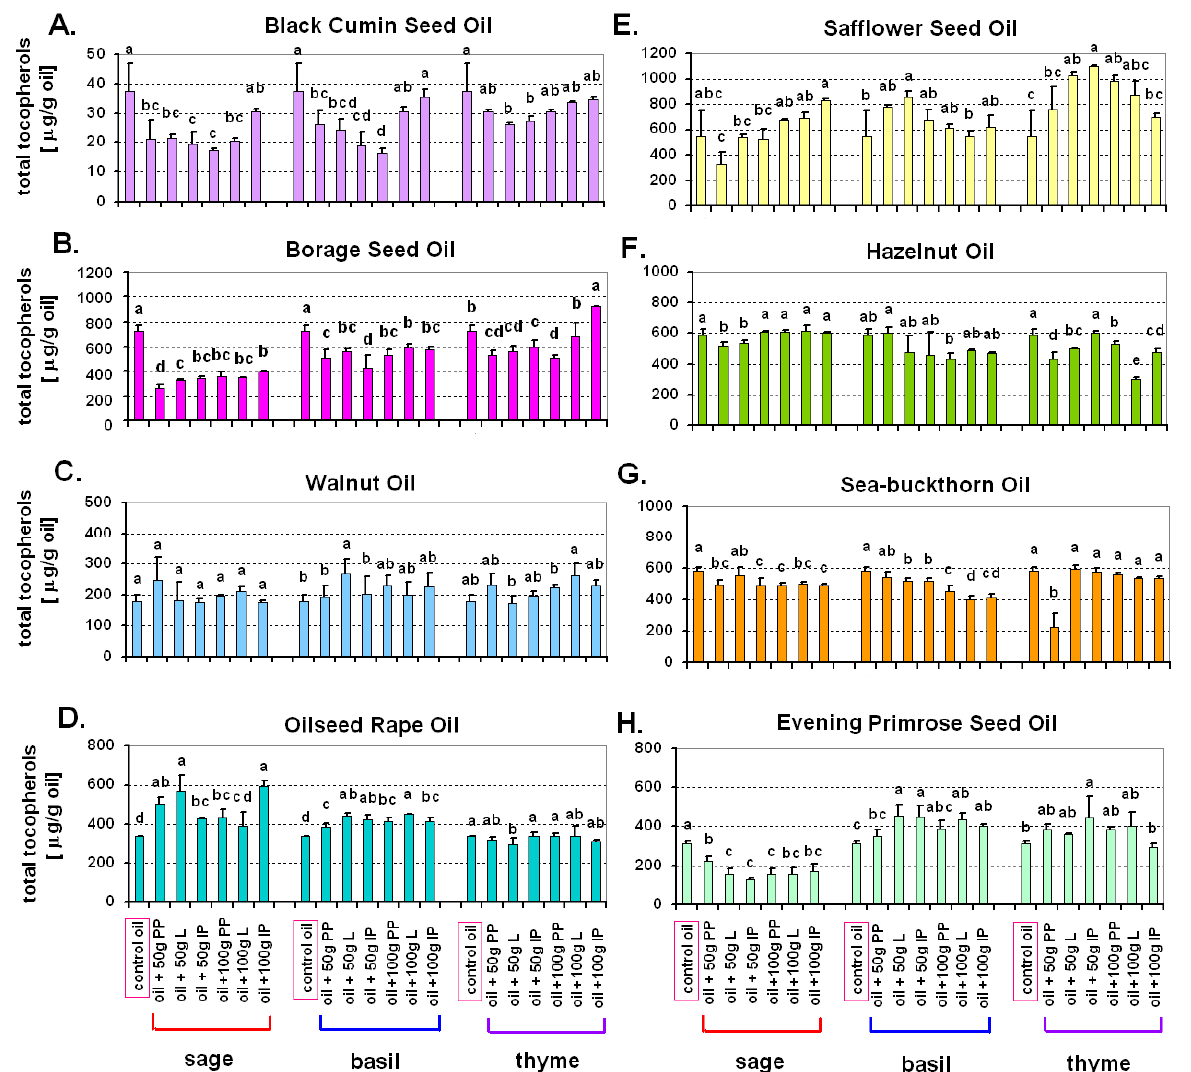
Figure 1. The impact of the addition of herbs (sage— Salvia officinalis L., basil— Ocimum basilicum L., thyme— Thymus vulgaris L.) on the content of total tocopherols in oils cold-pressed from the seeds of eight different species. ( A ) Black Cumin Seed Oil, ( B ) Borage Seed Oil, ( C ) Walnut Oil, ( D ) Oilseed Rape Oil, ( E ) Safflower Seed Oil, ( F ) Hazelnut Oil, ( G ) Sea-buckthorn Oil, ( H ) Evening Primrose Seed Oil. Control oil – cold-pressed oil without any additives. Values marked with the same letters are not significantly different according to the Duncan test ( p ≤ 0.05); statistical analyses made separately for individual herbs. PP—aerial plant part cut into pieces; L—leaves only; IP—intact aerial plant part.